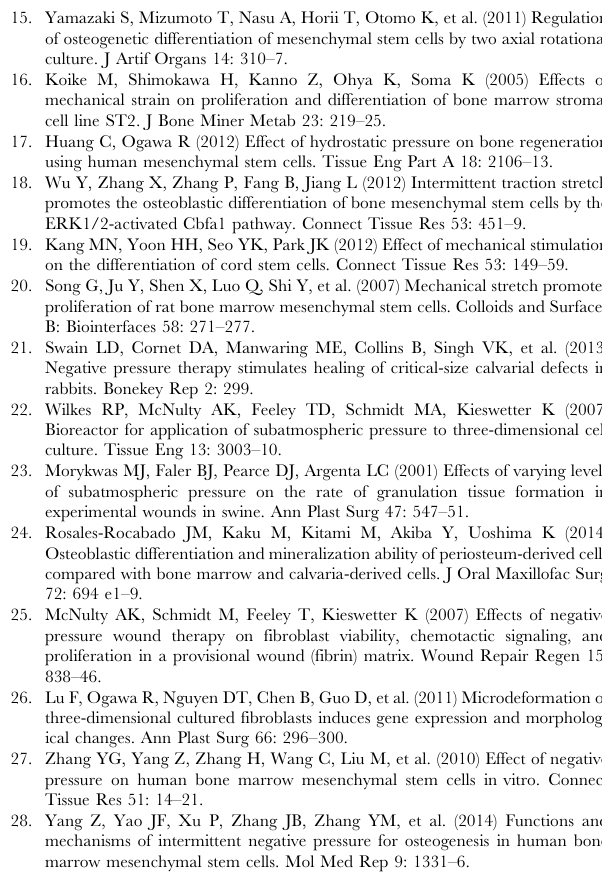
Figure S1 Characterization of P-MSCs. A : Cell surface markers of P-MSCs (Passage 3) were analyzed by Fluorescence- activated cell sorting (FACS). P-MSCs expressed CD44 and CD90, but not CD34, CD45. B : Adipogenic differentiation was confirmed using Oil Red-O staining ( 6 100). C and D : Osteogenic differentiation was revealed with ALP staining and alizarin red staining ( 6